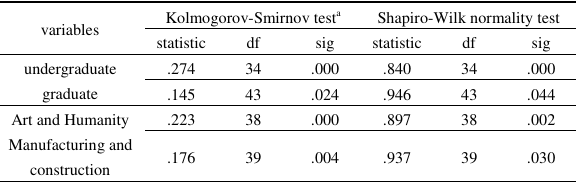
Table 3. Normality test of scores converted from content analysis